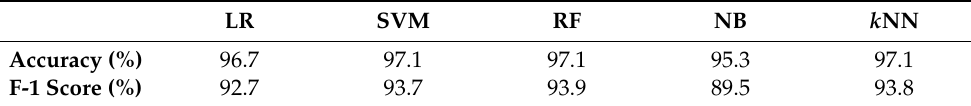
Table 2. Evaluation metrics of the algorithms after testing.